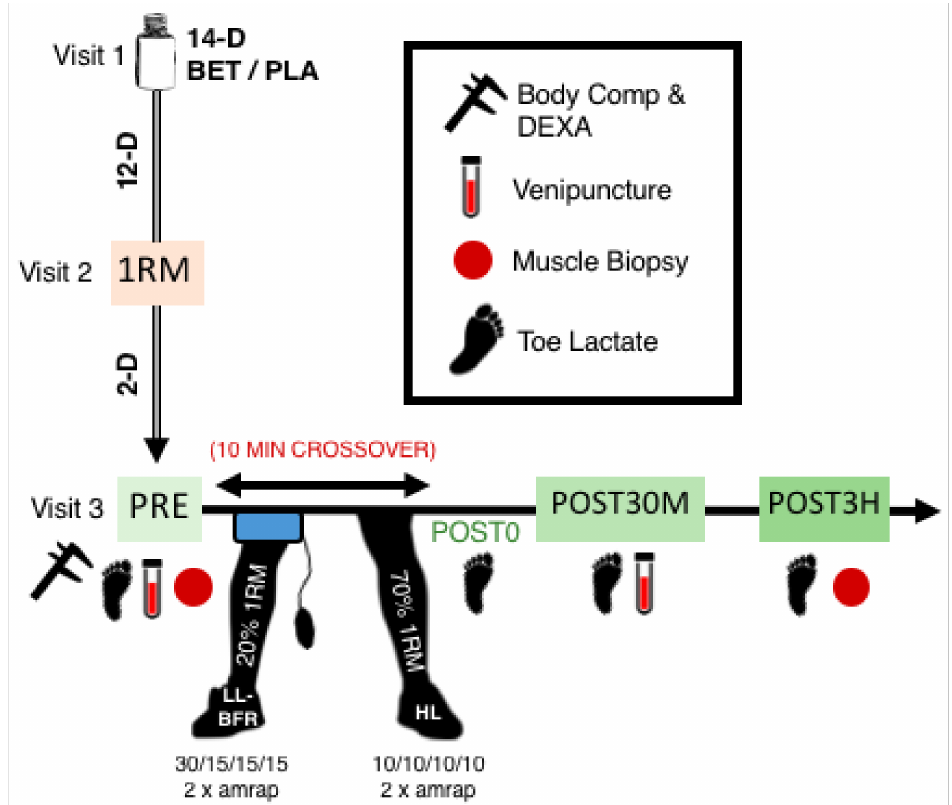
Figure 1. Study protocol and timeline visualization. 1RM = one-repetition maximum; amrap = as many repetitions as possible (to muscular failure); BET = betaine; DEXA = dual-energy x-ray absorptiometry; HL = high-load; LL-BFR = low-load blood flow restricted; PLA =